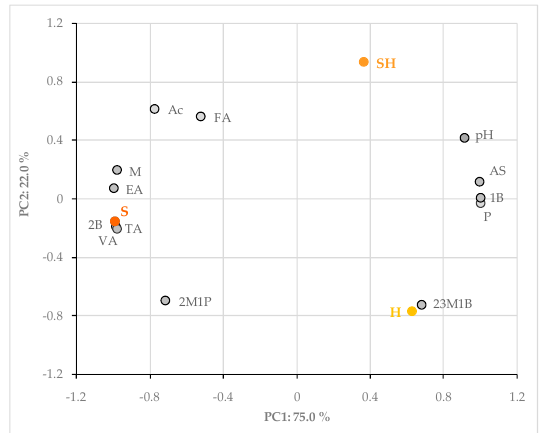
Figure 1. Principal component analysis (PCA) plot with all spirit drinks and chemical characteristics. AS, Alcohol strength; TA, Total acidity; FA, Fixed acidity; VA, Volatile acidity; M, Methanol; Ac, Acetaldehyde; EA, Ethyl acetate; 2M1P, 2-Methyl-1-Propanol; P, 2-propen-1-ol; 1B, 1-Butanol; 23M1B, 2 + 3-Methyl-1-Butanol. SH, new spirit drink made with strawberry tree fruit and honey; S, arbutus spirit; H, honey